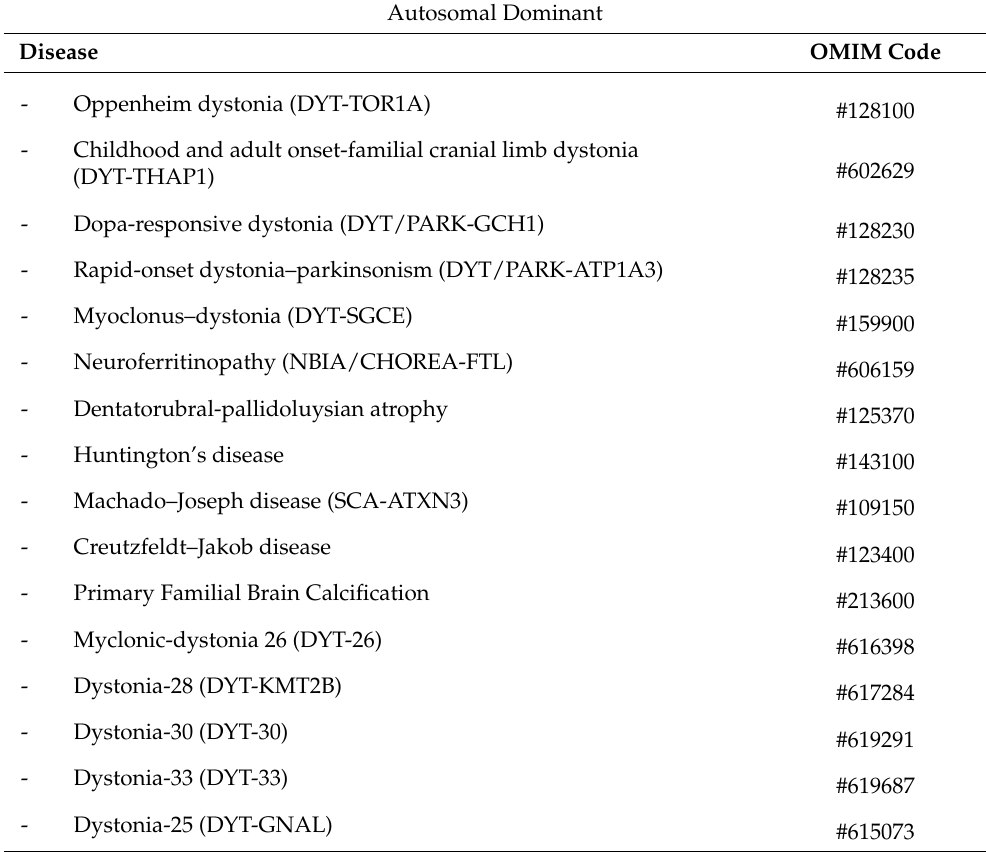
Table 3. Inherited causes of dystonia.